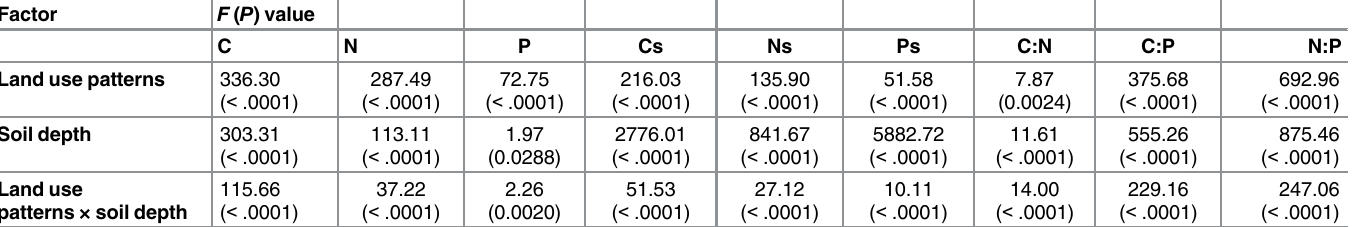
Table 1. F and P values for the effects of land use patterns and soil depth on the soil C:N:P stoichiometry in the hilly area of Loess Plateau, China. These three factors concern soil stocks or ratios.